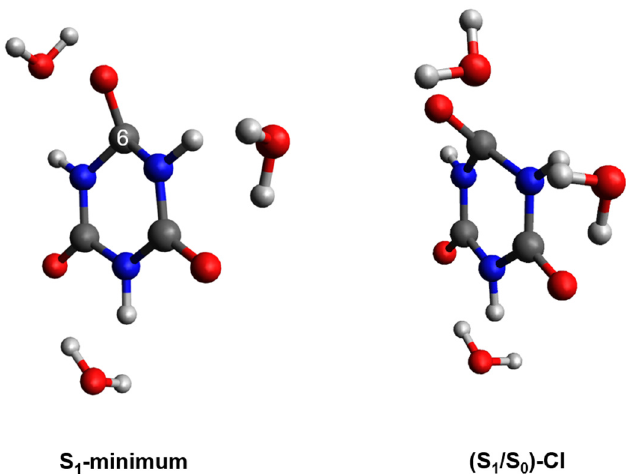
Figure 3. Optimized S 1 minimum-geometry and the (S 1 /S 0 ) CI along the C6-puckering coordinate obtained for microsolvated CA at the TD-X3LYP/C-PCM/cc-pVDZ in water.